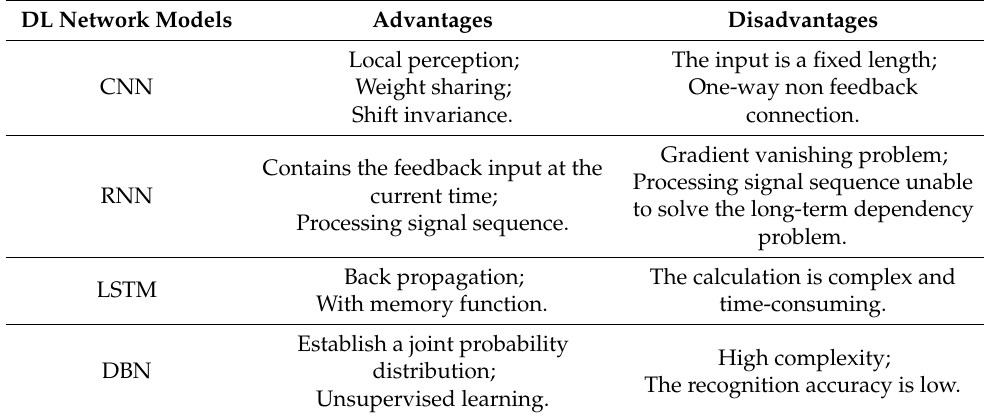
Table 15. Advantages and disadvantages of the DL network model. DL Network